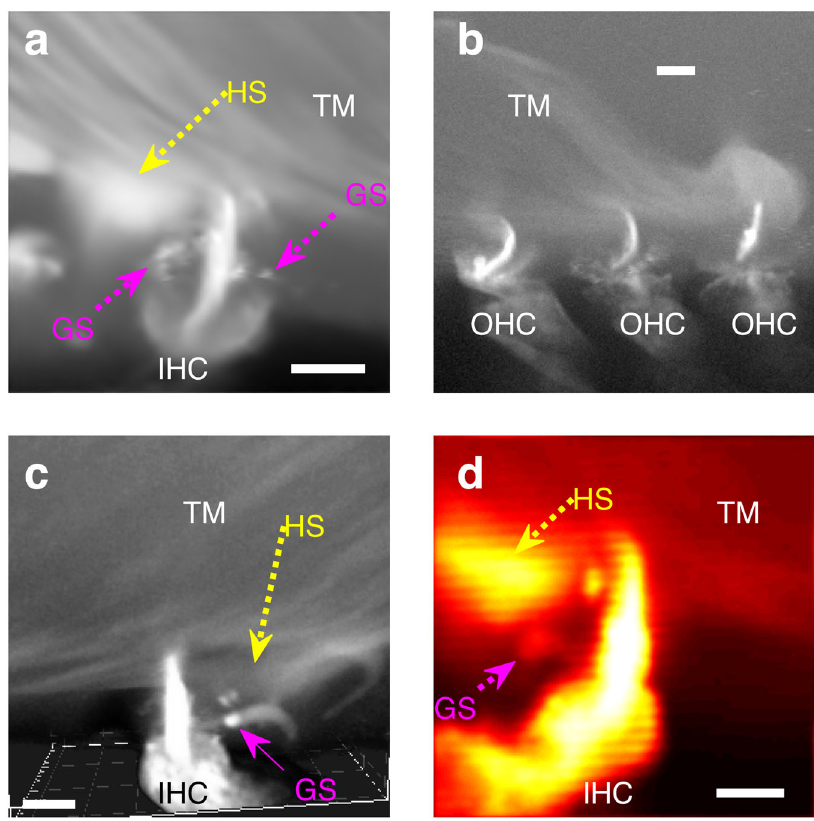
Fig. 6 IHC stereocilia are fully TM-embedded. a , b The confocal images of the (dextran-conjugated) zFluor-stained OC show that zFluor stained the IHCs and OHCs as well as the TM. In addition, the zFluor fl uorescence patterns revealed fi lamentous structures that contacted the stereocilia in similar fashion as the Ca 2 + ducts, suggesting that the Ca 2 + ducts had electrical properties that activated zFluor. The dye stained also the granular structures (GSs) as well as the Hensen ’ s stripe (HS) most likely due to the associated electrical environments. c 3D reconstruction of the IHC and the associated TM region. The 3D structure was rotated to show the opposite side of the view seen in a . Again, the GSs and Ca 2 + duct-like structures can easily be visualized. In addition, some GSs surprisingly localized close to the cell ’ s cuticular plate, which is part of the RL, as seen in Fig. 4a, supporting that the TM-embedded the entire length of the IHC stereocilia bundles. The 3D reconstruction was prepared in Imaris 9.2 from 35 z-stacks with a z-step of 1 µ m. d High-speed confocal image of the IHC stereocilia and the associated TM region captured during acoustic stimulation with a 1 kHz-tone, i.e., 5x their best frequency, and at 103 dB SPL. Again, the IHC stereocilia bundle can be seen TM-embedded even when stimulated with such a high frequency tone. The GS captured between the HS and the stereocilia bundle suggests that some GSs could have a connective role that links the HS to the base and tip of the stereocilia bundle. Data in a – d were representative of fi ve different preparations. All scalebars 5 µ